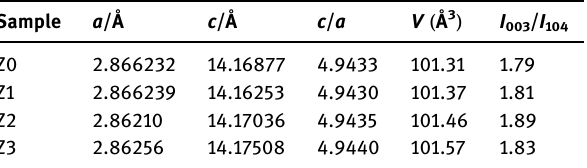
Table 2: Lattice parameters of pristine and ZnO -